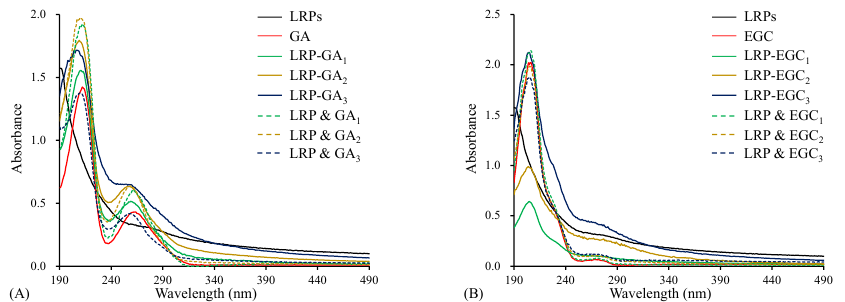
Figure 3. The UV–Vis spectra of LRPs, polyphenols, LRP-phenol complexes, and their physical mixtures. LRPs, GA, LRP-GA complexes, and their physical mixture ( A ); LRPs, EGC, LRP-EGC complexes, and their physical mixture ( B